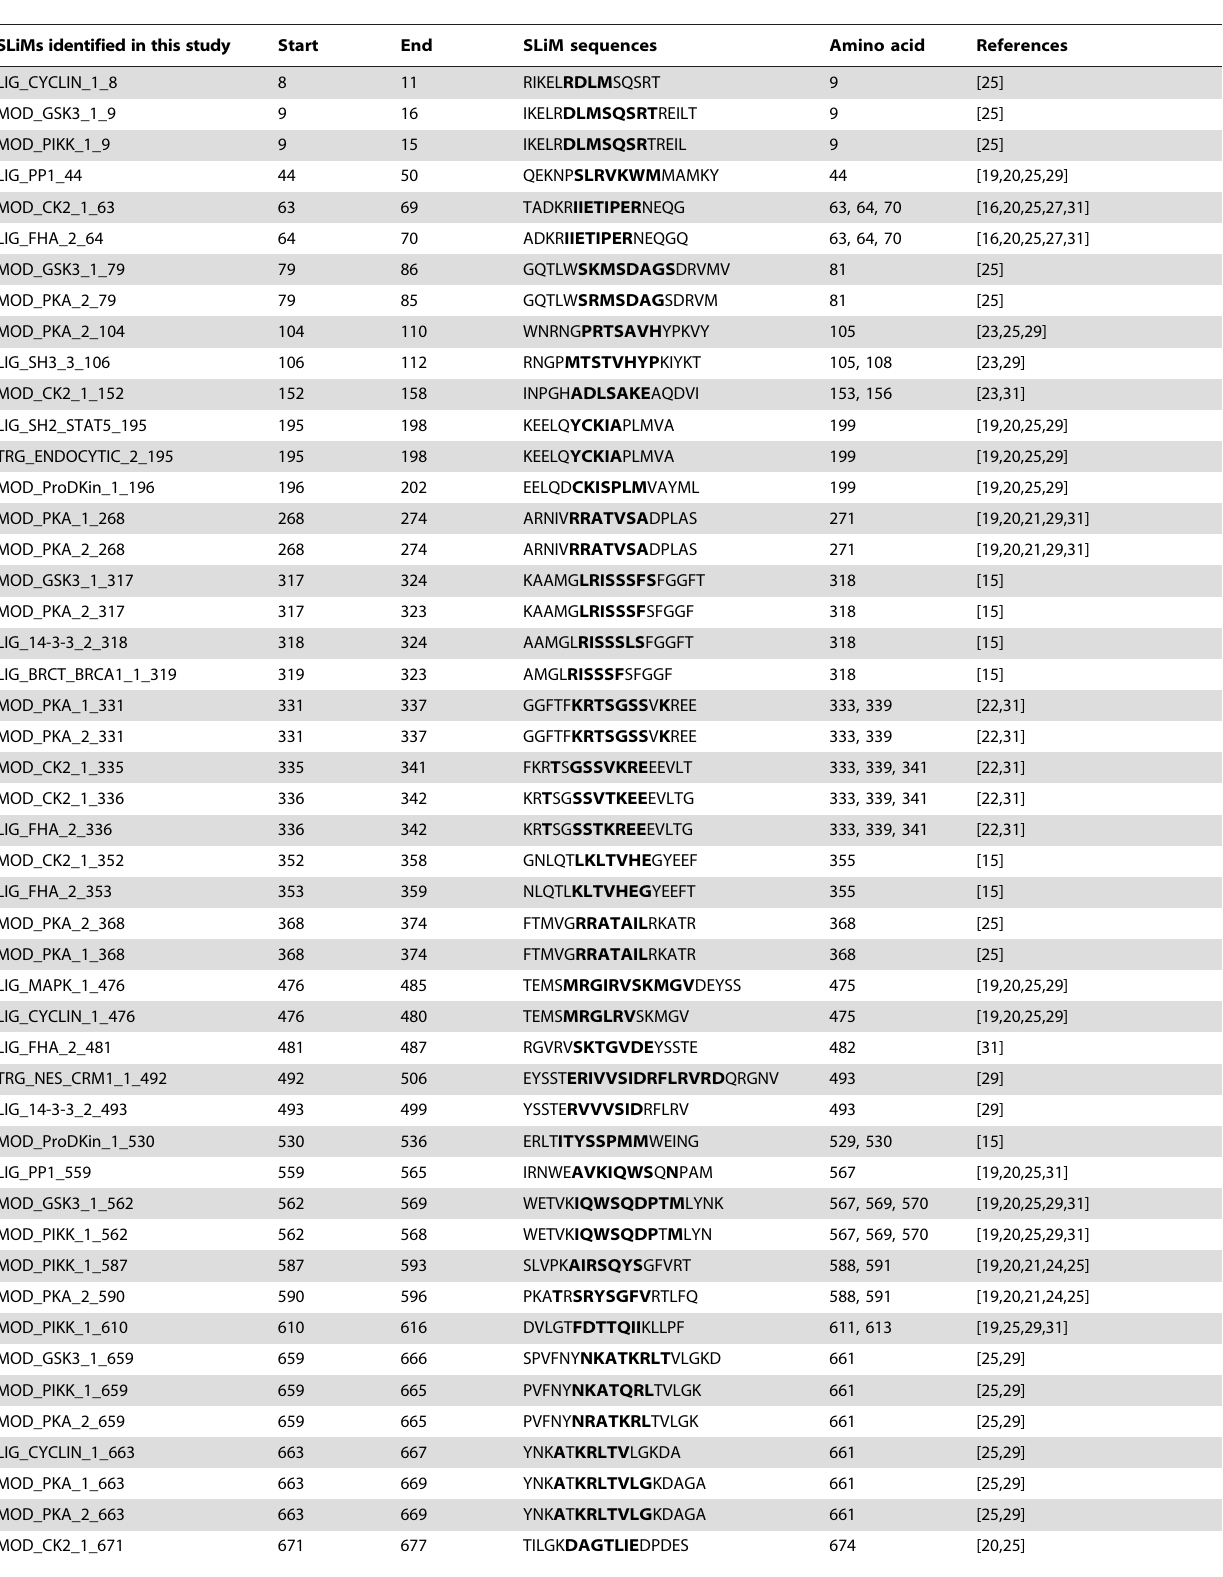
Table 4. SLiMs mapped to the vicinity of amino acids that were reported as genetic signatures or are associated with the adaptation of IAV PB2 proteins to the